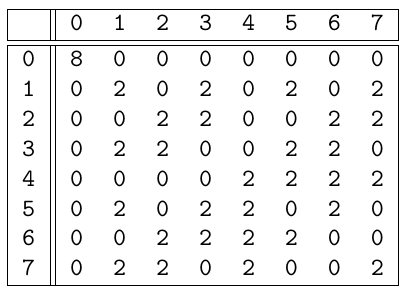
Table 1: DDT of the 3-bit Sbox used in